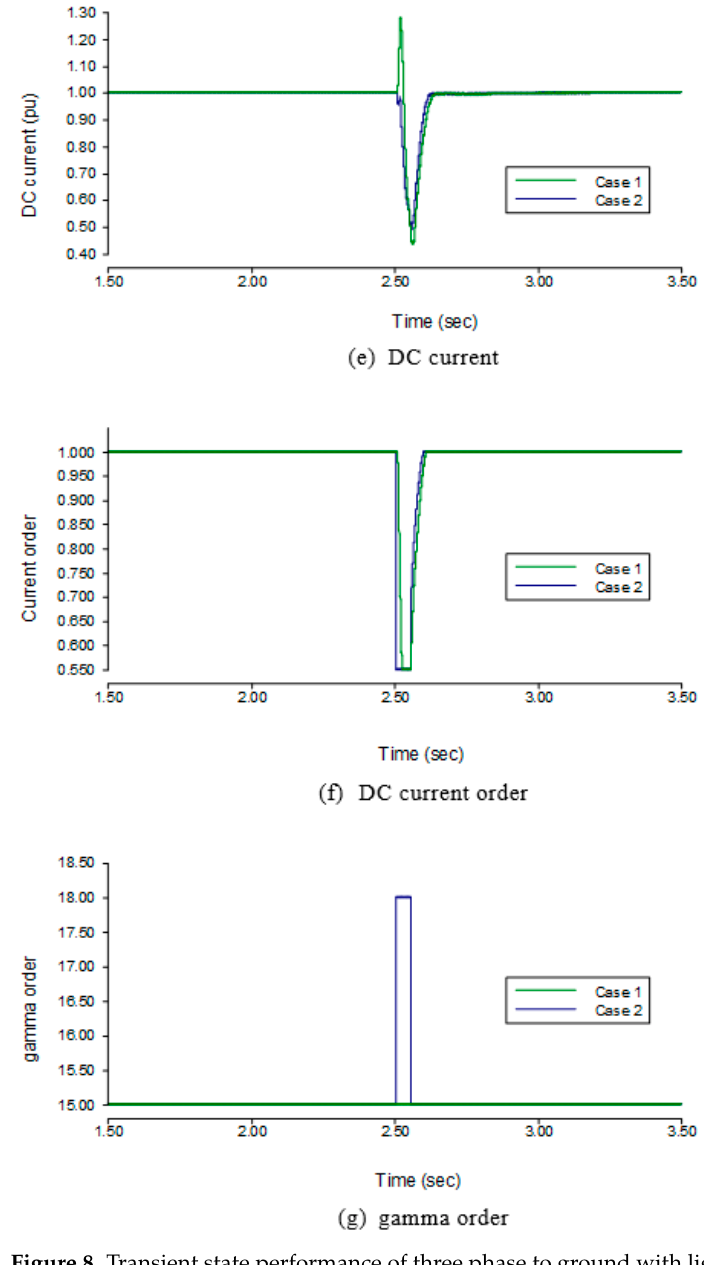
Figure 8. Transient state performance of three phase to ground with light AC fault.